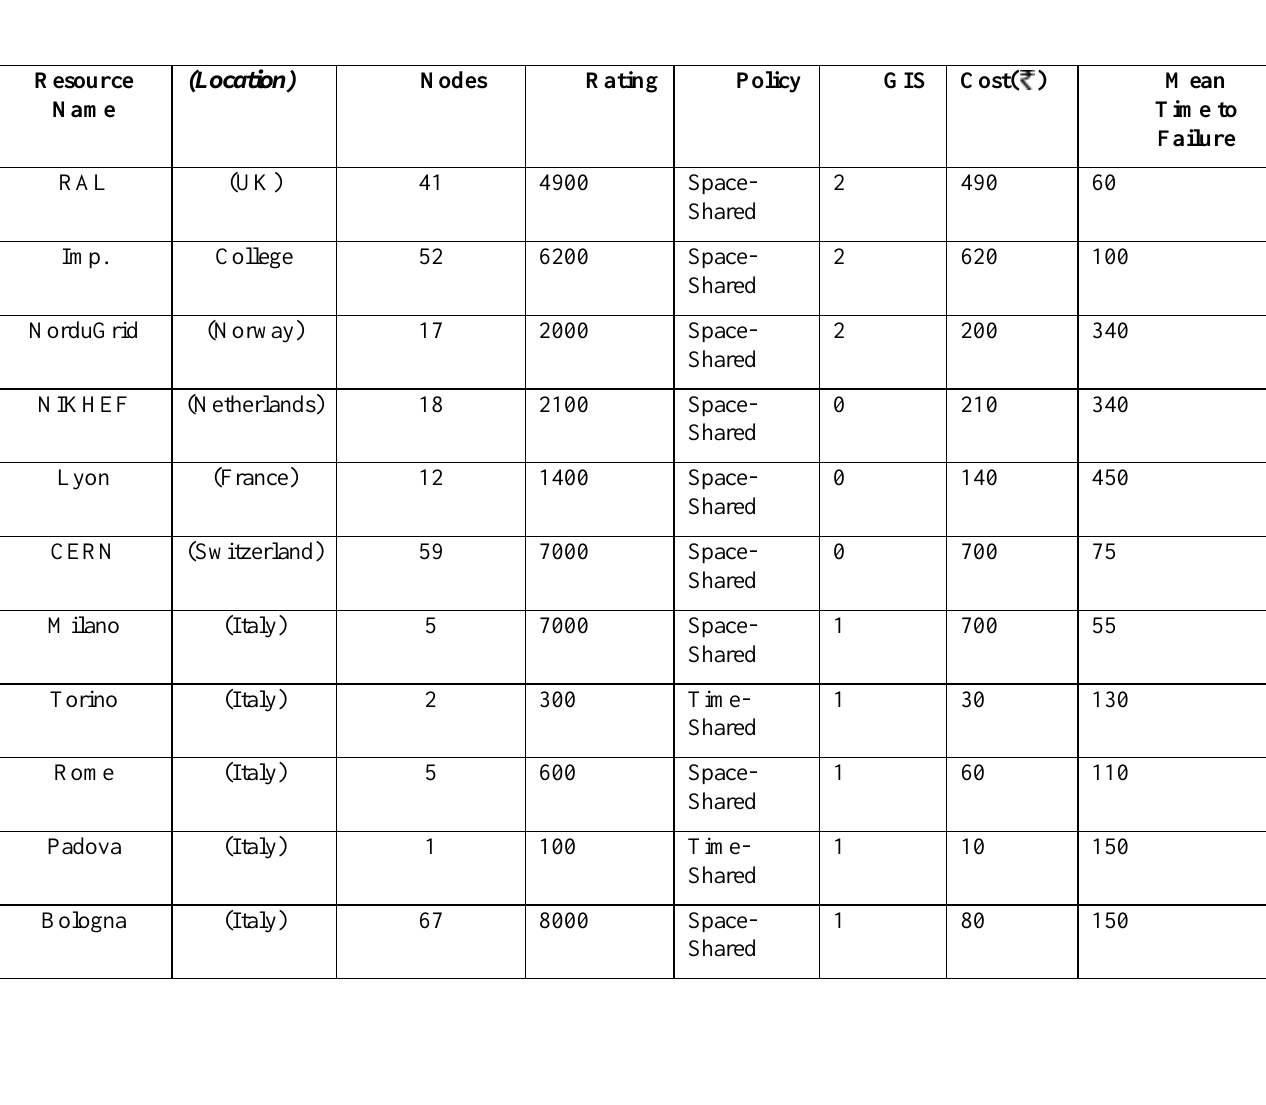
Table 2. Simulation